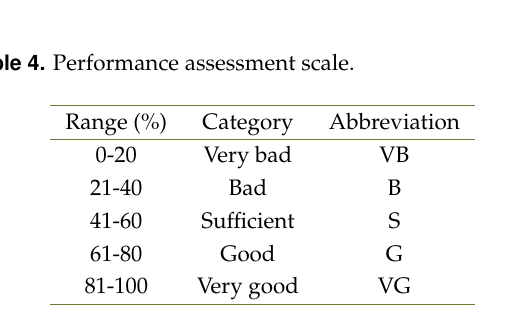
Table 5. Spearman correlation assessment